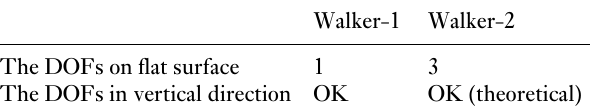
Table 3 The DOFs of the